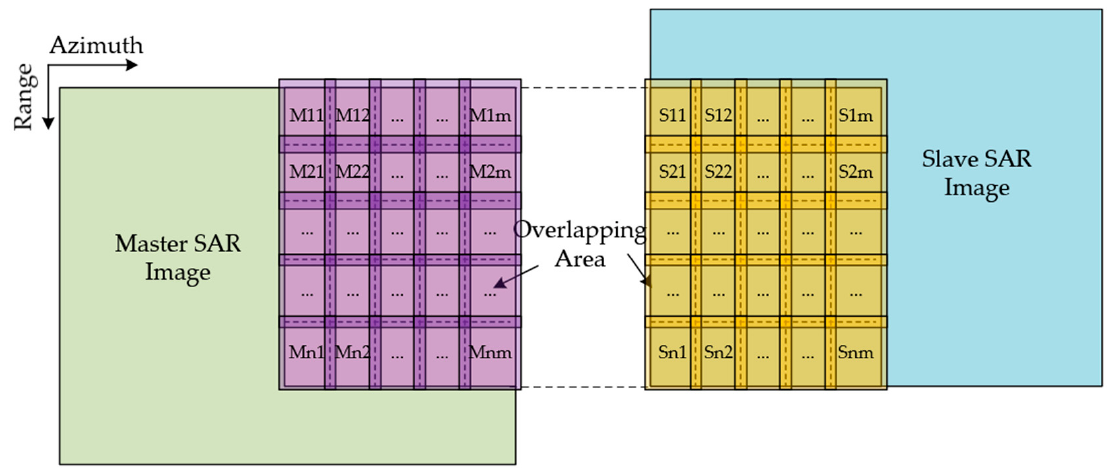
Figure 4. Diagram of image blocking.